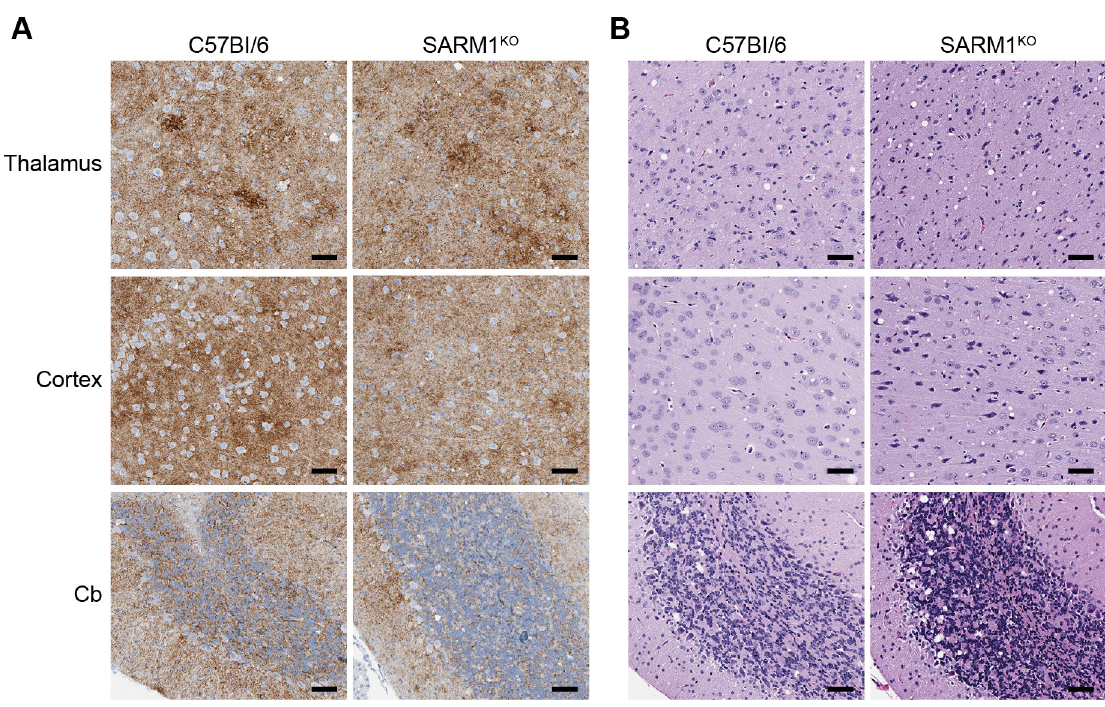
Fig 4. The pattern of PrP Sc deposition and spongiform change in the brain are similar at the clinical stage of disease in SARM1 KO and C57Bl/6 mice inoculated IC with RML prions. (A) PrP Sc staining in the thalamus, cortex, and cerebellum (Cb) of clinically positive C57Bl/6 (155 DPI, left panels) and SARM1 KO (148 DPI, right panels) mice inoculated IC with RML prions. PrP Sc was detected using the anti-PrP rabbit monoclonal antibody EP1802Y as described in the materials and methods. (B) H&E staining of the thalamus, cortex, and cerebellum from clinically positive C57Bl/6 (155 DPI, left panels) and SARM1 KO (148 DPI, right panels) mice inoculated intracranially with RML prions. For all panels, scale bar = 50 μ m.